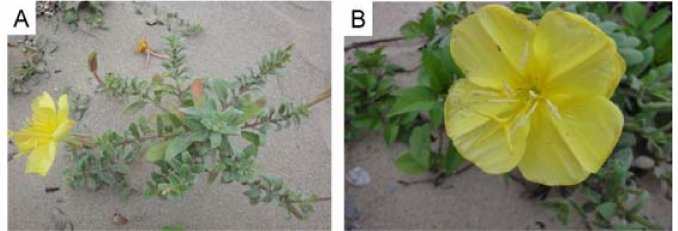
Figure 6. The pictures of O. laciniata, showing the aerial part ( A ) and the flower ( B